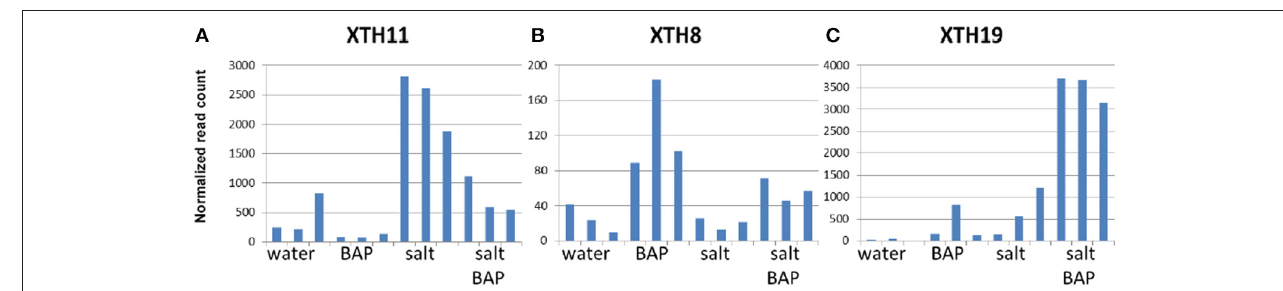
FIGURE 11 | Effect of CK on differential expression of XTH11 , XTH 8, and XTH19 genes under salinity stress. (A) XTH11 gene expression (B) XTH8 gene expression (C) XTH19 gene expression. Arabidopsis w.t. plants were grown for 30 days in optimal conditions and then leaves were detached and exposed to BAP 10 µ m, 120mM NaCl, or salt plus BAP for 24h. Controls were detached leaves in water. Three samples were collected from the controls and stressed leaves.